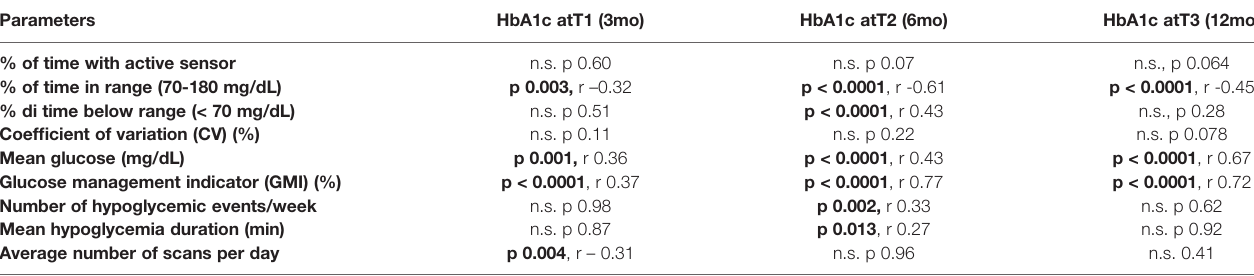
TABLE 4 | correlations among HbA1c and study variables at T1, T2 and T3 in group A. Parameters